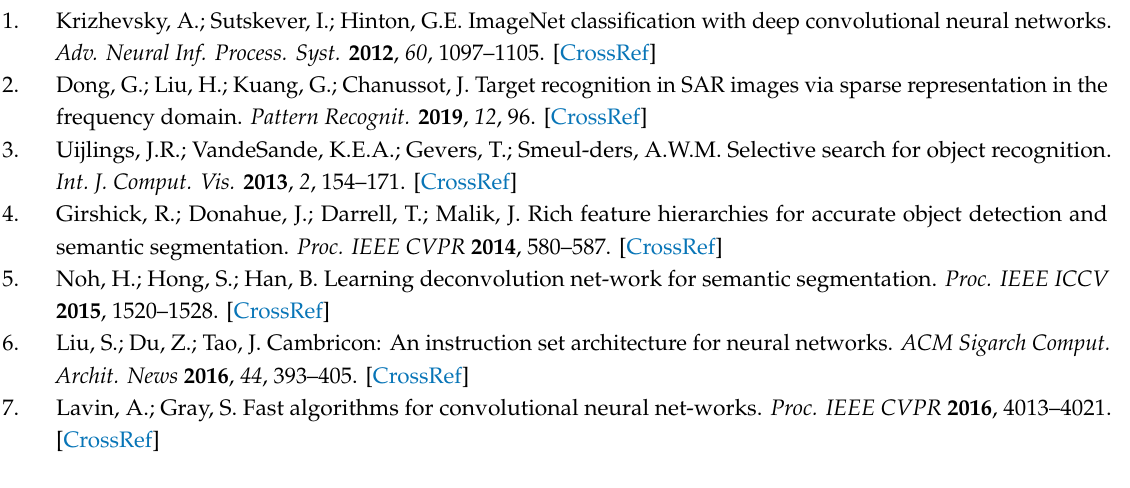
Figure 17. Per unit power operation Performance of different processors handling cov8.